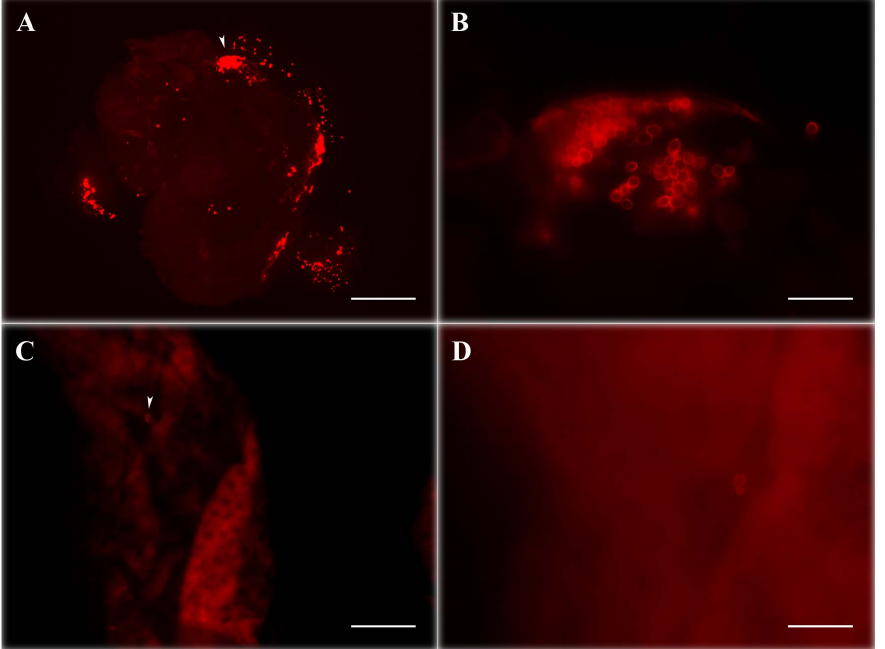
Figure 3. Wa F17.12-KT fluorescence signal comparison in female mosquito midguts with or without yeast introduction. Female mosquito midguts on the 10 th day after feeding with sugar solution enriched with stimulated Wa F17.12 (A and B) and sterile sugar solution (C and D). Red stained yeasts are abundantly visible in (A), while only few cells are detected in the control sample (C). Images B and D (bar=20 m m) are magnification of samples shown in A and C respectively (bar=200 m m) White arrow in A and C indicates the section of sample enlarged in B and D.